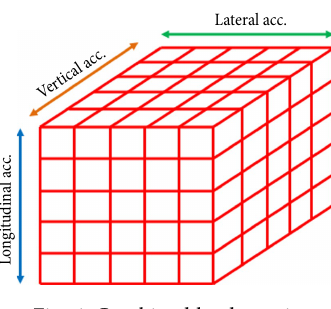
Fig. 6. Combined load matrix